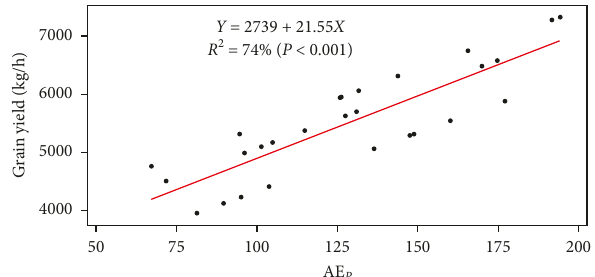
Figure 3: Relationship between agronomic phosphorus use effi- ciency and grain